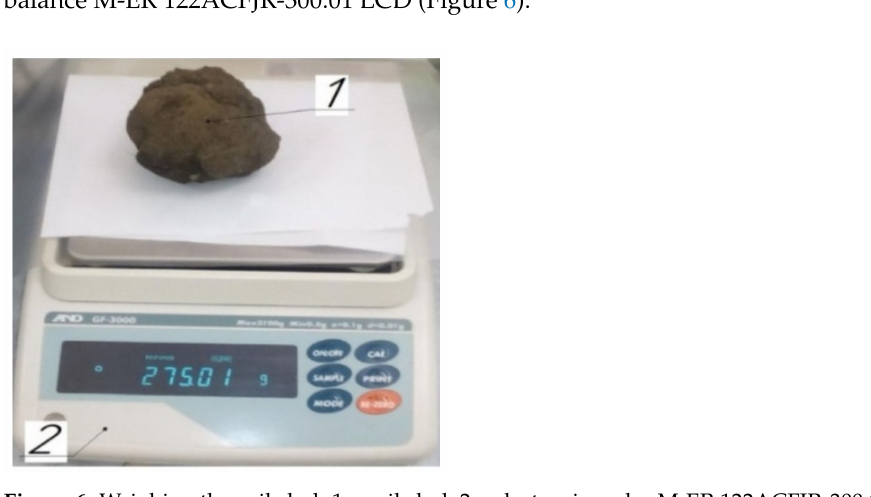
Figure 6. Weighing the soil clod: 1—soil clod; 2—electronic scales M-ER 122ACFJR-300.01 LCD. The dimensions of the soil clods were determined with a caliper (Figure 7), which provides a measurement accuracy of 0.02 mm.